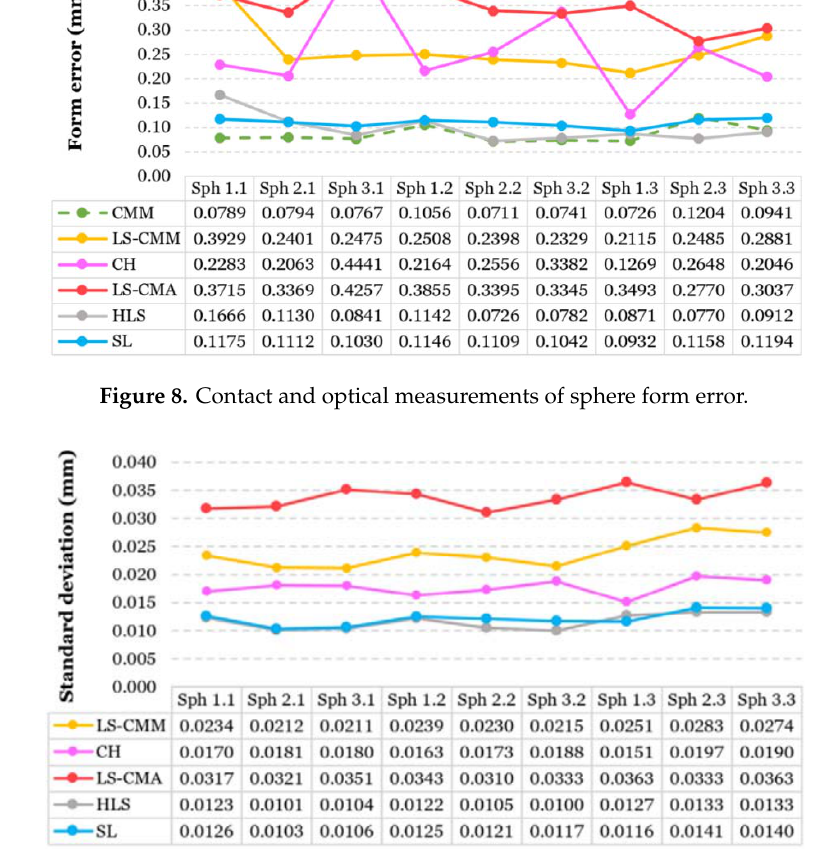
Figure 8. Contact and optical measurements of sphere form error.